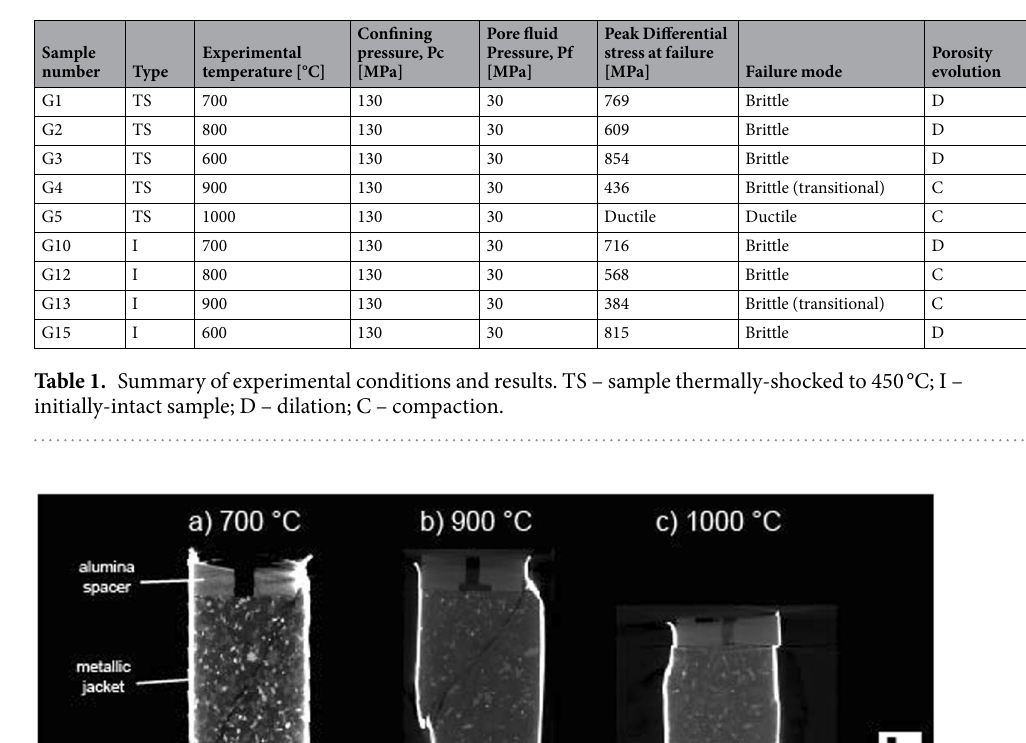
(Fig. 2b). The porosity of the samples deformed at 800 and 900 °C both decreased by ~2% up to an axial strain of ~1%, before remaining pseudo-constant for the remainder of the experiment (Fig. 2b). At the end of the experi- ment, the samples deformed at 600 and 700 °C had increased, while the samples deformed at 800 and 900 °C had decreased (Fig. 2b).